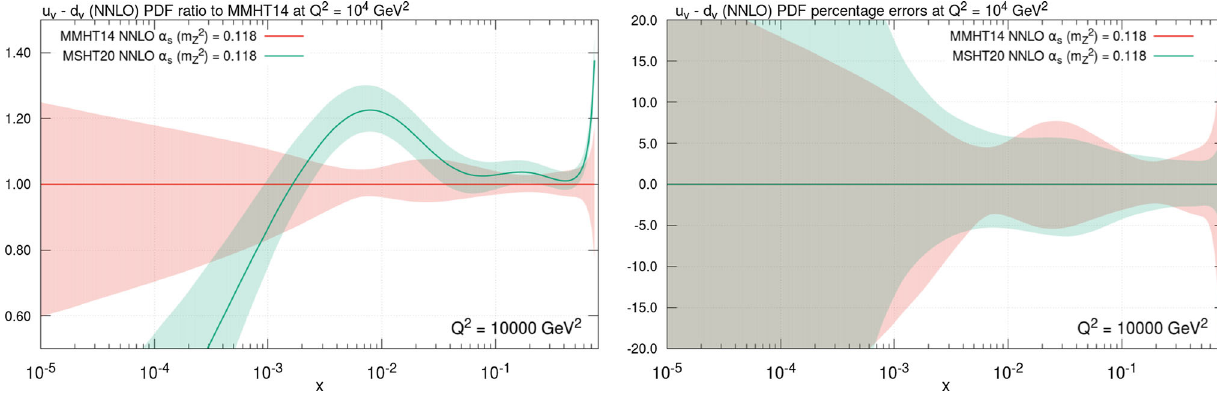
Fig. 24 u V − d V PDF, for MSHT20 and MMHT14 at NNLO and Q 2 = 10 4 GeV 2 . (Left) ratio to MMHT14. (Right) percentage